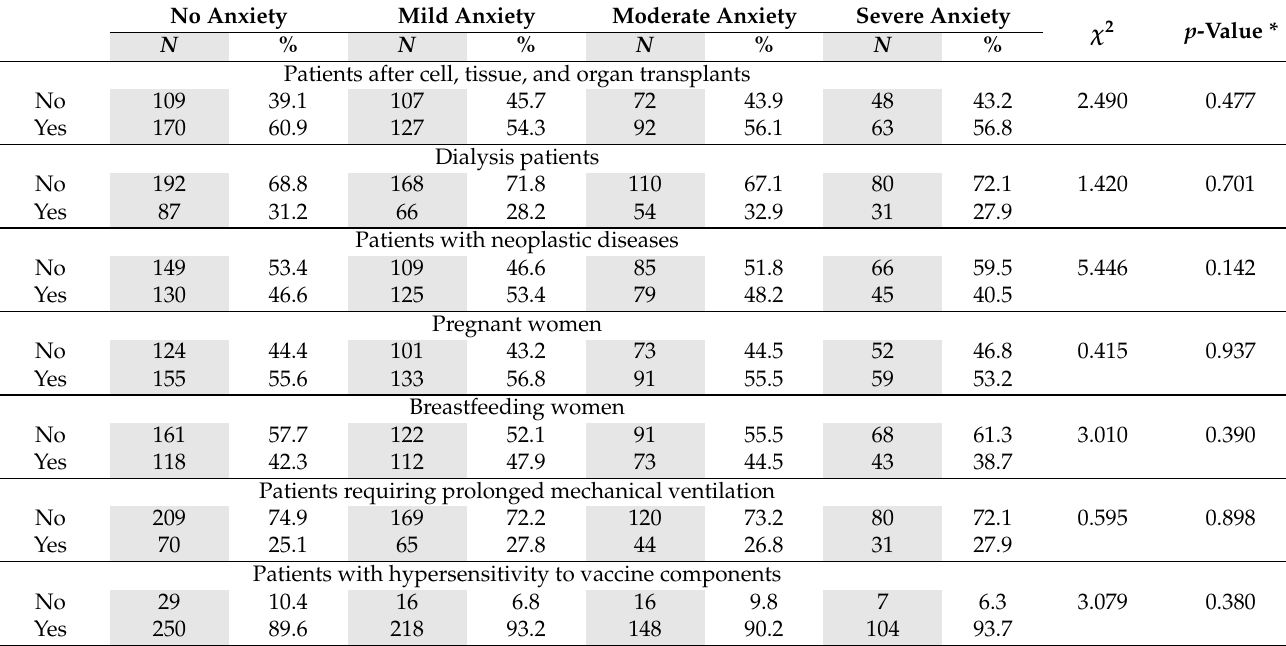
Table 6. Contraindications to vaccination and anxiety